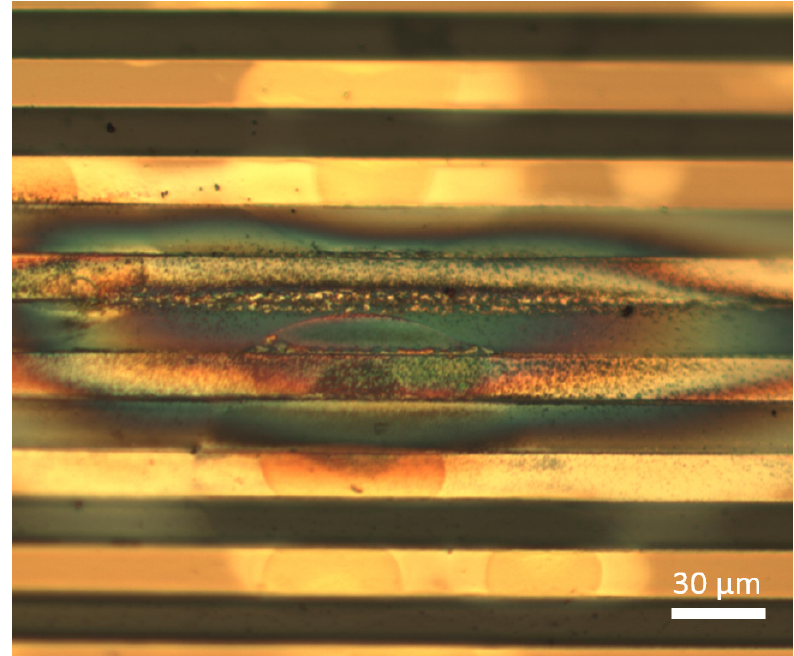
Figure 1. Gold conducting paths (30 µm pitch) of a flexible ECoG array embedded in two 5 µm thick polyimide layers. The array was used for long-term electrical stimulation tests in vitro in saline so- lution to investigate the electrode coating stability of PEDOT: PSS. Due to delamination between the polyimide layers and continuous electrical current pulses, gold dissolved and formed a thin gold layer, which led to short circuits between the conducting paths.